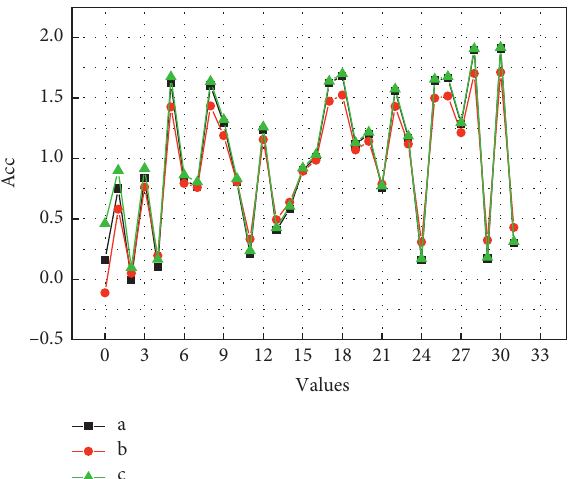
Figure 5: The m AP plots of the three base networks.